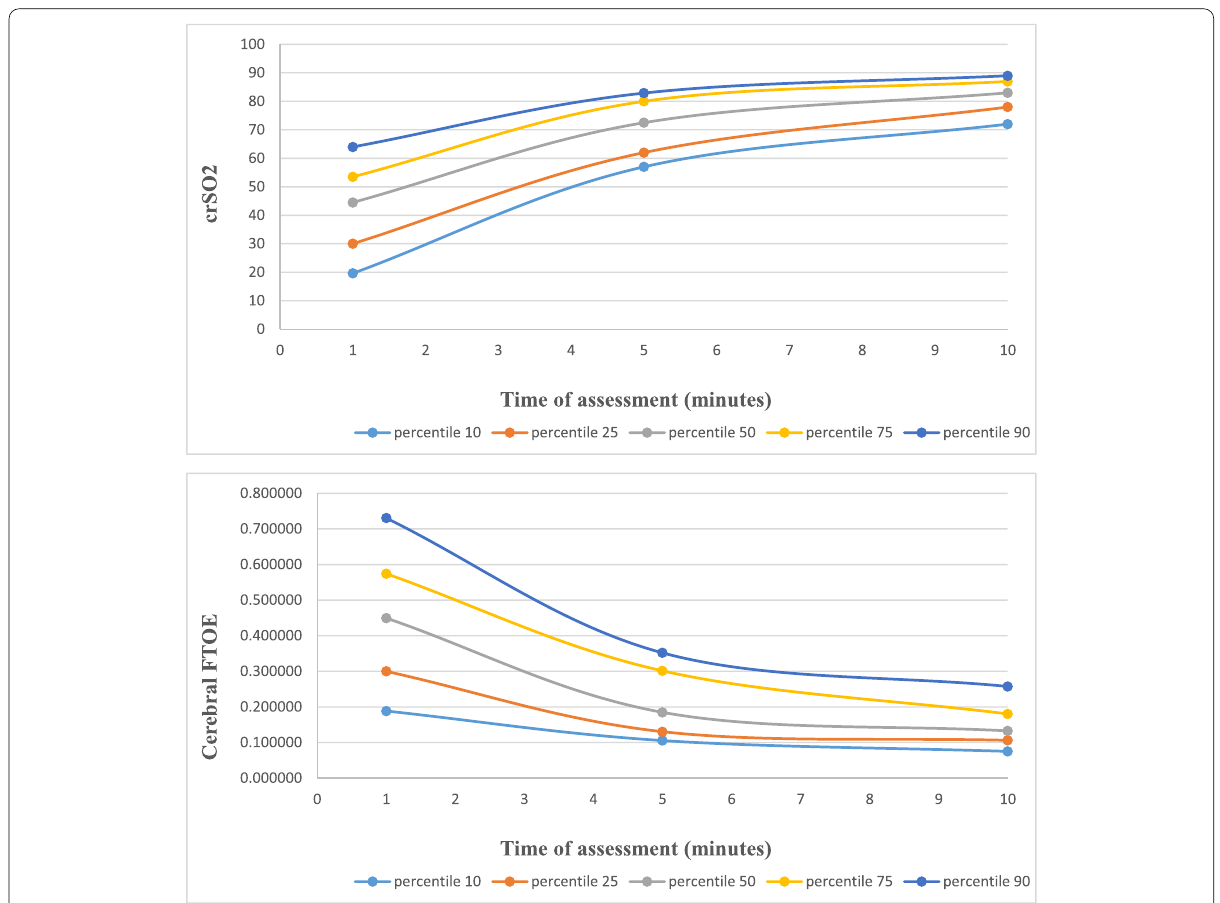
Fig. 1 Centile charts for cRsO2 and FTEO at 1, 5, and 10 min after birth in healthy full‑term